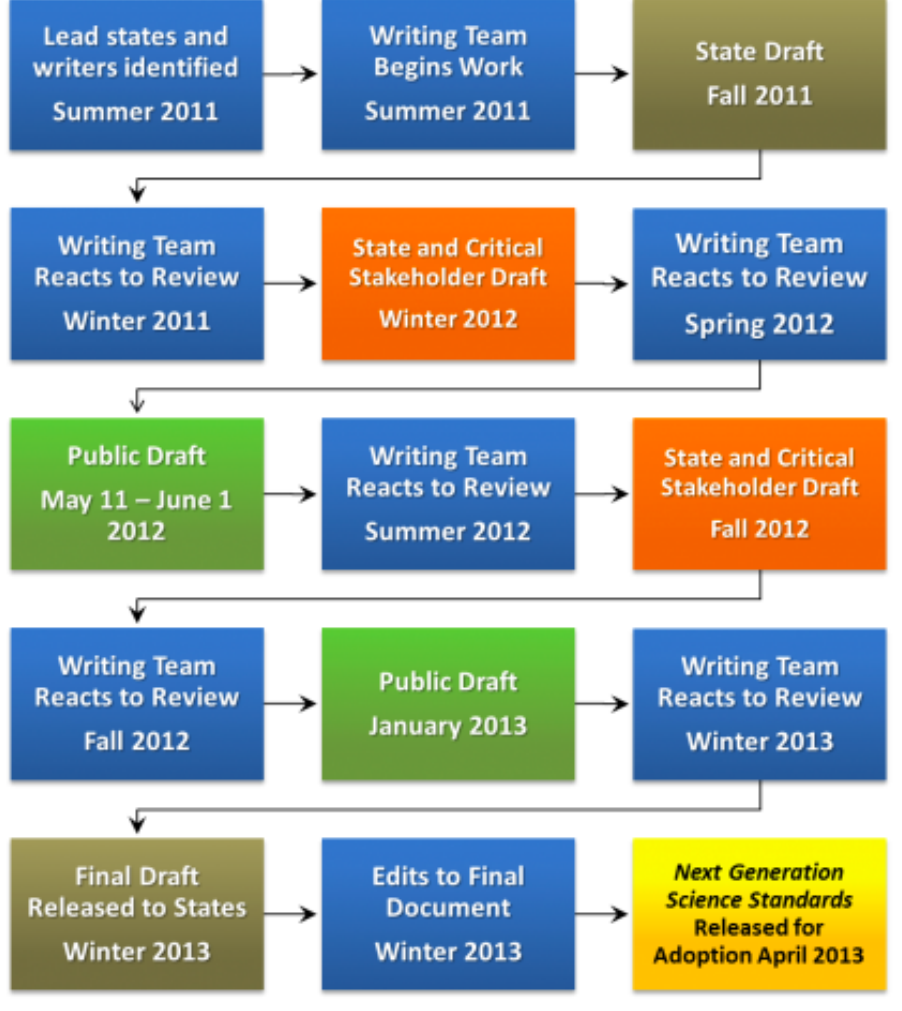
Figure 1: Visual representation of the second stage of the NGSS completion process (NGSS Lead States,